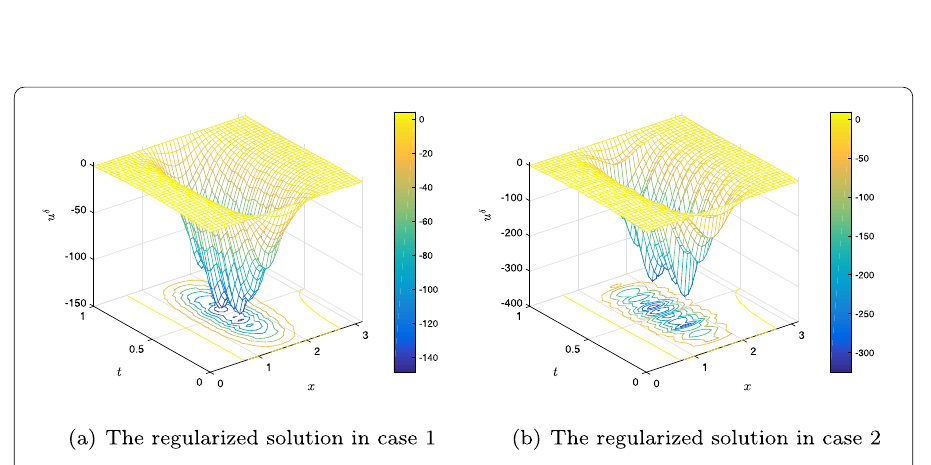
Figure 5 A comparison between the regularized solution in case 1 and case 2 for α = 0.8, δ = 0.1, and